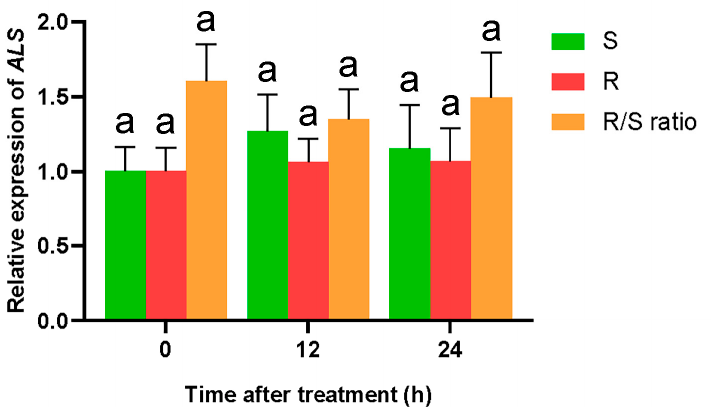
Figure 4. ALS gene expression levels relative to control at 0, 12, and 24 h after bensulfuron-methyl administration in C. difformis plants. Different letters represent a significant difference ( p < 0.05). No obvious difference (fold change < 2, p > 0.05) was detected in the ALS expression between the R (BBHY1) and S (HFLJ1) plants.